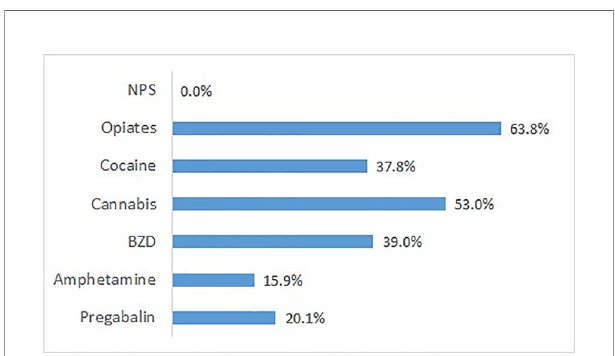
FIGURE 5 | Substances found by GC/MS analysis of urines sampled at admission, except prescribed medication (n = 181 patients from fi ve detoxi fi